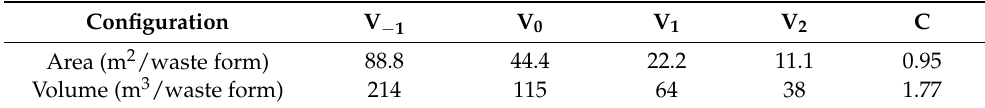
Table 12. Areas and volumes used by Nishihara et al. [73] for different vertical (V) and compact (C) emplacement